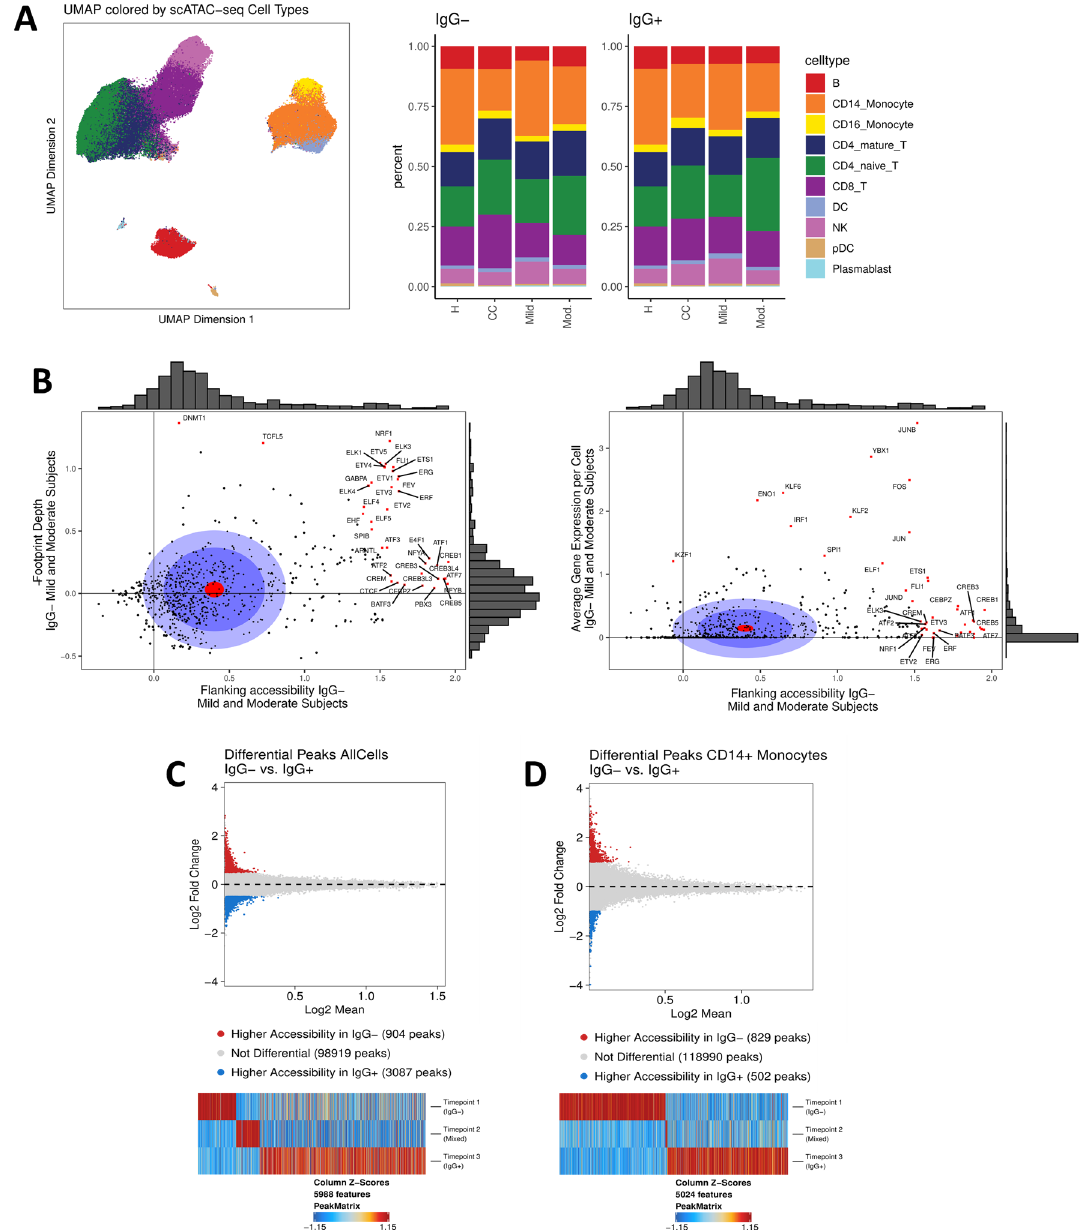
Figure 3. Epigenetic signatures in cells collected from COVID-19 subjects evolve with disease progression. ( A ) Uniform manifold approximation and projection (UMAP) plot of single-cell ATAC-seq data generated from healthy controls, uninfected close contacts, and COVID-19 subjects with mild or moderate symptoms (left). Relative abundance of cell types represented in the scATAC-seq data are plotted for each group at IgG− and IgG+ timepoints for COVID-19 subjects and collection day 0 and 14 for close contacts (right). ( B ) Transcription factor motif accessibility and binding activity measured by footprint depth (left) or average per-cell gene expression (right) in COVID-19 subjects with mild or moderate symptoms. Distribution of accessibility and gene expression are plotted as histograms along the axes (gray). The red circle is the average of all points; the dark blue circle is 50% of all data; the light blue circle is 75% of all data. Motifs with the top 5% change in flanking accessibility are plotted in red. ( C ) Differentially accessible chromatin between IgG− and IgG+ timepoints in all cells and ( D ) CD14+ monocytes. Differentially accessible chromatin observed across the IgG−, mixed and IgG+ timepoints in COVID-19 subjects is shown where significance is defined as p ≤ 0.05 and absolute LFC ≥ 0.5 (top); Changes in differentially accessible chromatin are shown across time